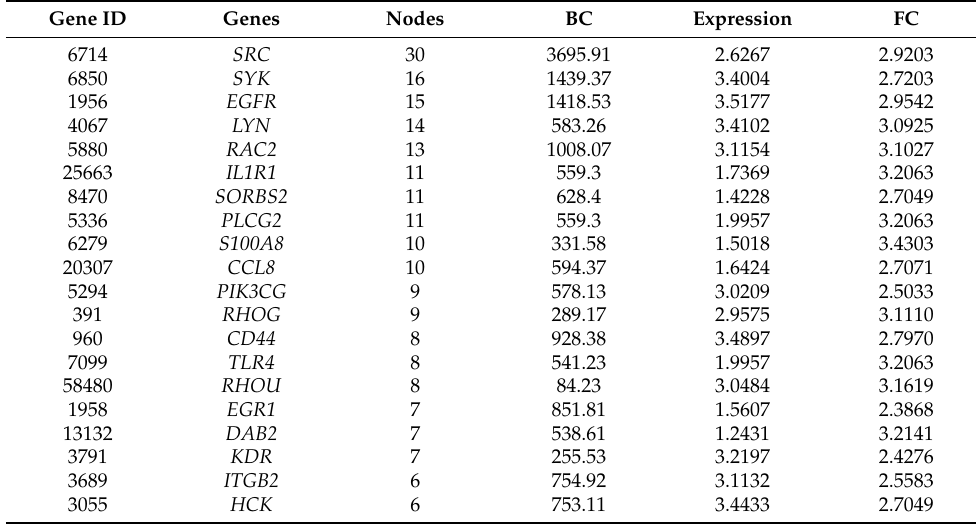
Figure 6. The protein–protein interactions in the turquoise module. The gradual color change from green to light green and brown to light brown represents expression intensity. The turquoise module was akin to the connectivity degree in the co-expression network, correlated negatively in the brown and correlated positively in the green nodes. The perimeters of the nodes were analogous to the fold change (FC). Table 3. The most common hub genes of co-expression and PPI networks of GBM. Gene expression and Fold Change (FC) values are converted log 2 base, and Betweenness Centrality